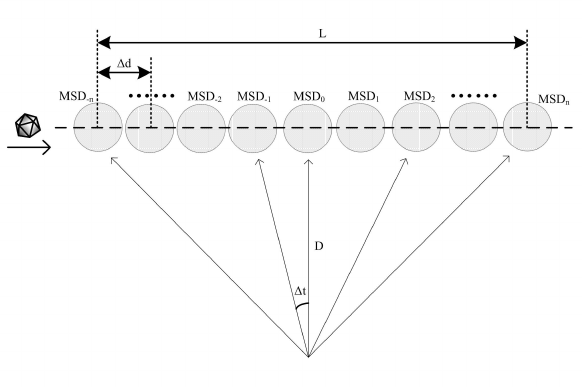
Figure 10. Derivation of appropriate jetting